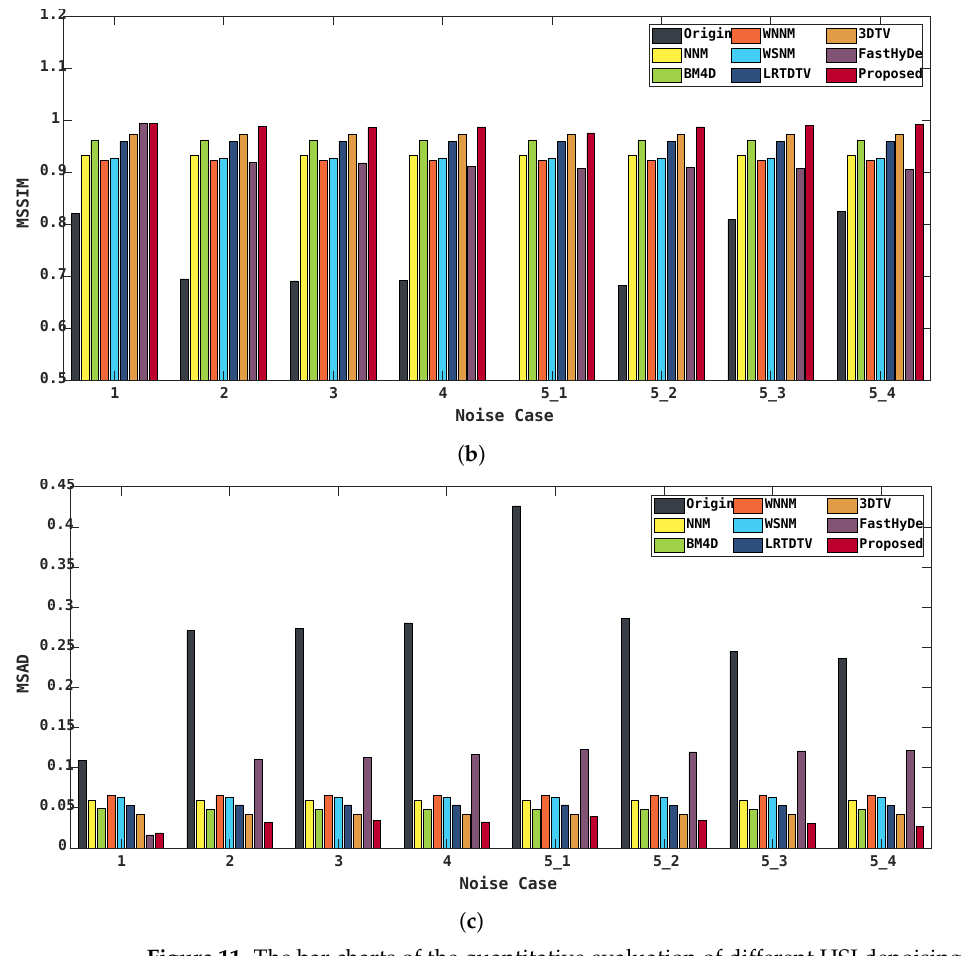
Figure 11. The bar charts of the quantitative evaluation of different HSI denoising methods on five noise cases: ( a ) MPSNR (dB); ( b ) MSSIM; and ( c ) MSAD.